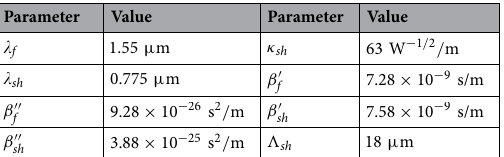
Table 1. Parameters of the pulsed-SHG process in the PPLN optical waveguide according to Ref. 18 .